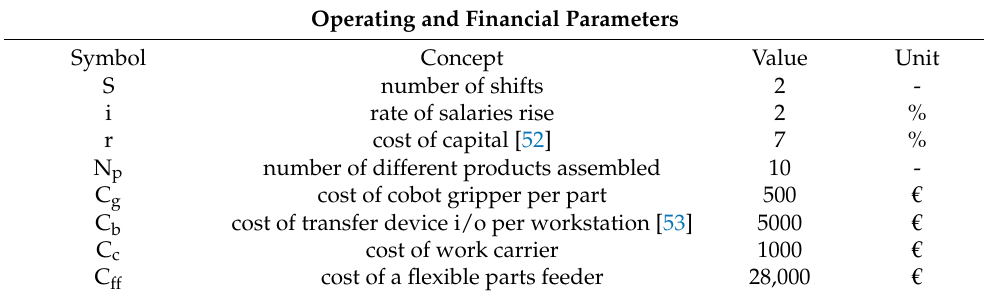
Table 2. Parameter selection for the model of differential cost in assembly with collaborative